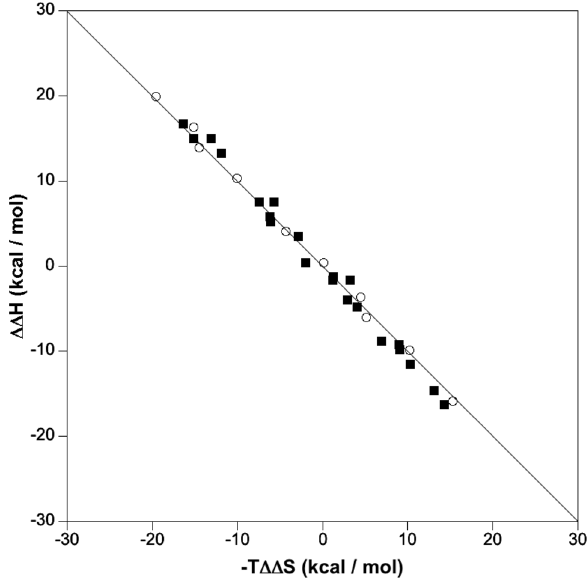
Figure 4. ∆∆H versus -T∆∆S plot of experimental differences, compiled from the ITC data of Table 3 at 298 K, for pairs of ligands binding to human DNPH1 (open circles) and rat DNPH1 (black squares). The line corresponds to full enthalpy-entropy compensation (∆∆H = T∆∆S). doi: 10.1371/journal.pone.0080755.g004 contacts are observed and little stabilization of the complexes occurred. As the three distinct complexes are likely to represent good templates for the modeling of the binding mode